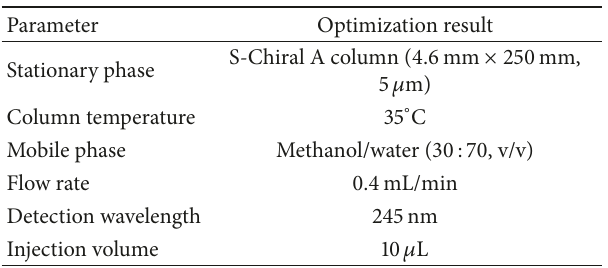
Table 1: Optimized conditions for (R, S)-goitrin enantiomer sepa-